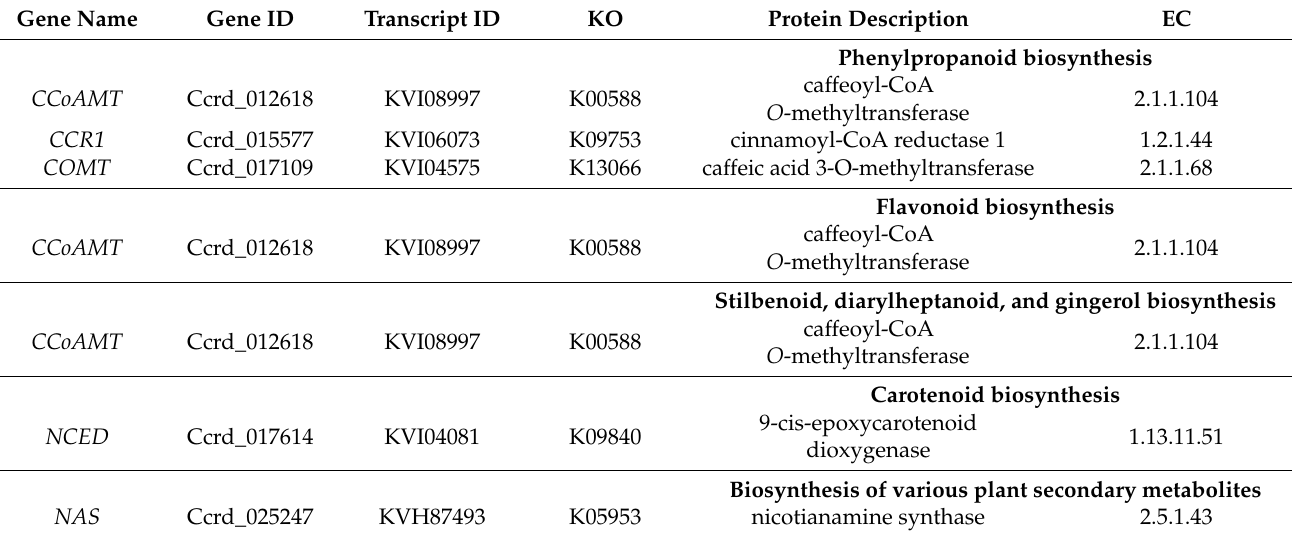
Table 3. Differentially expressed genes (DEGs) involved in the biosynthesis of secondary metabo- lites in common between sanitized Locale di Mola (LM) and Troianella (TR). The relative protein description, KEGG orthology (KO) entry, and EC number are also indicated in the